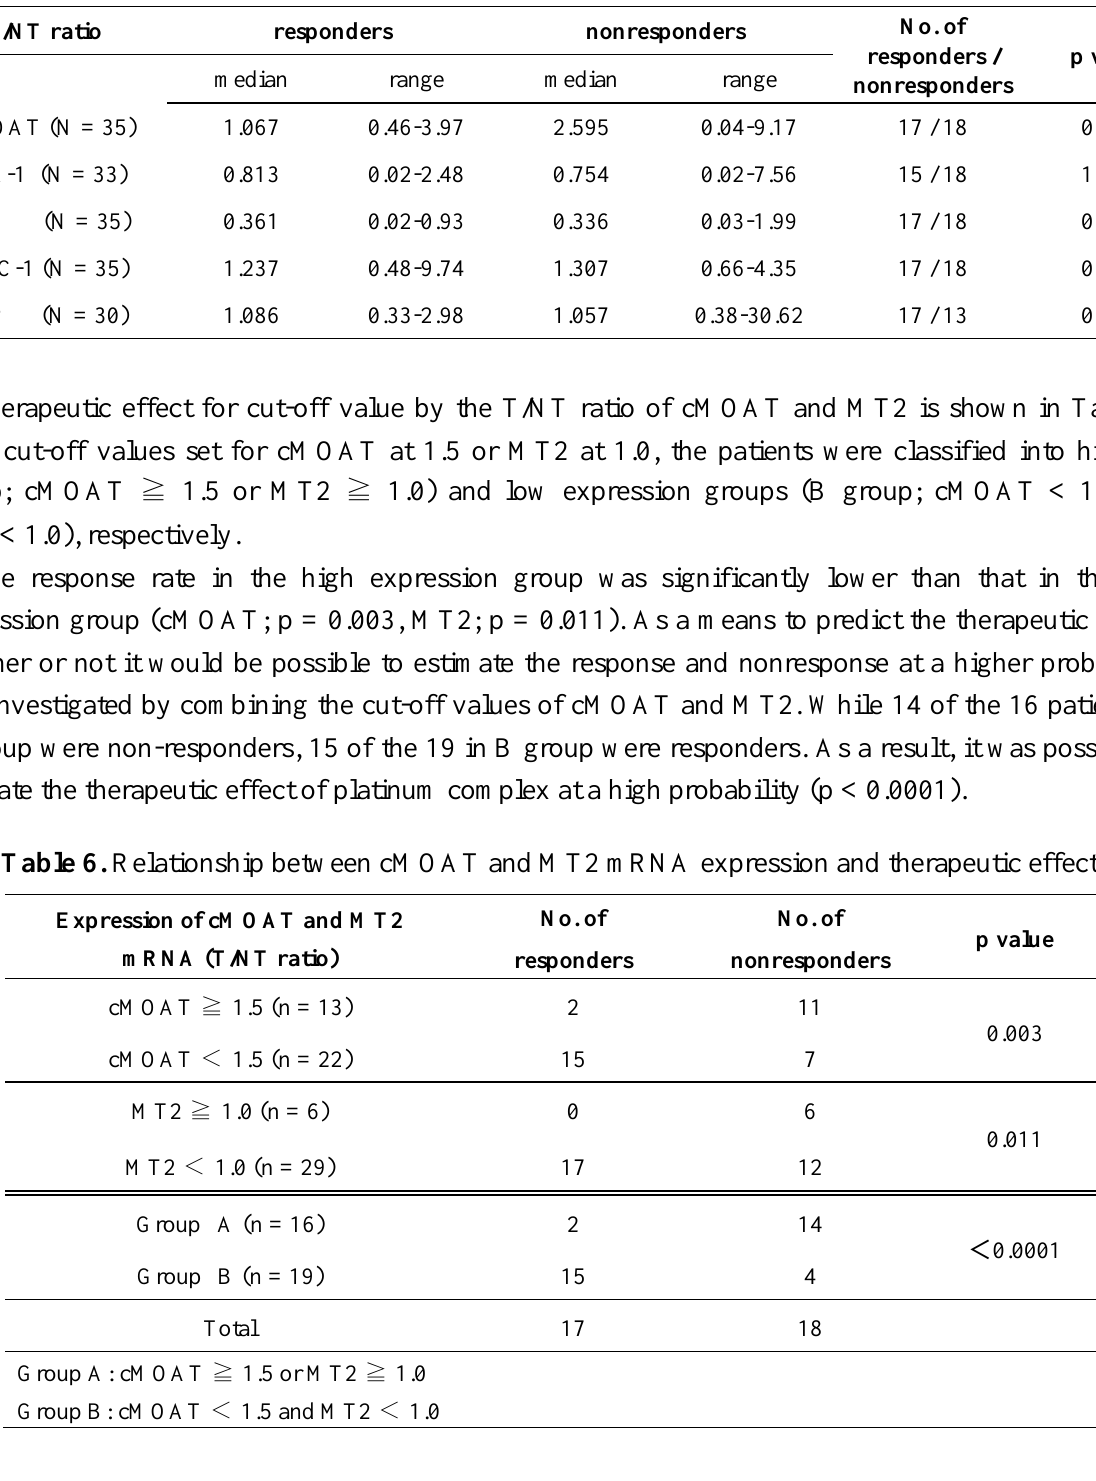
responders / p value nonresponders